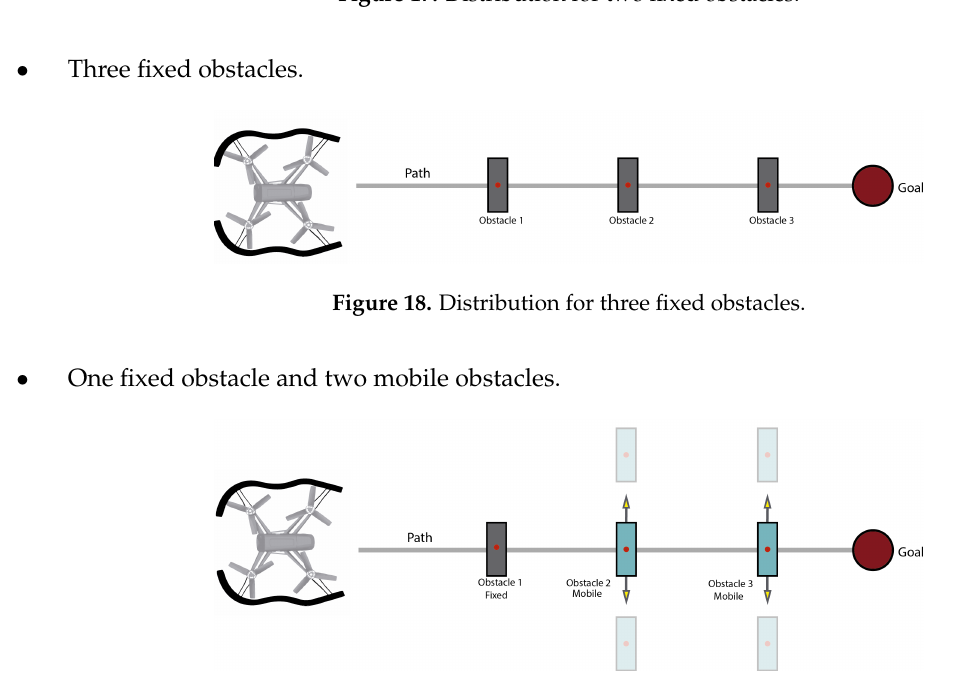
Figure 19. Distribution for one fixed obstacle and two mobile